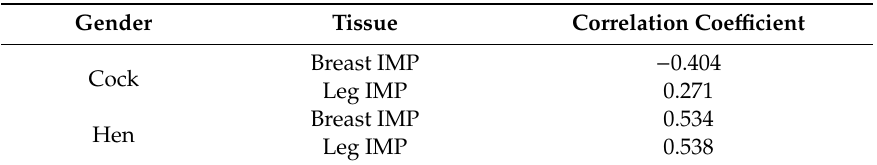
Table 6. Analysis of the correlation between IMP content and AK1 mRNA expression in the breast and leg muscles of Jingyuan chickens.